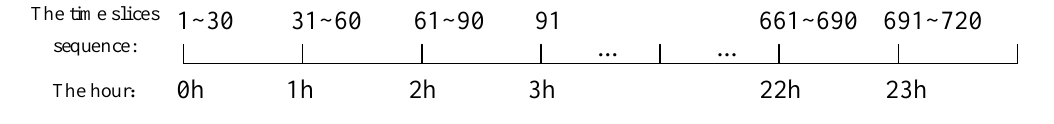
Figure 3. Sequence number of time slices.